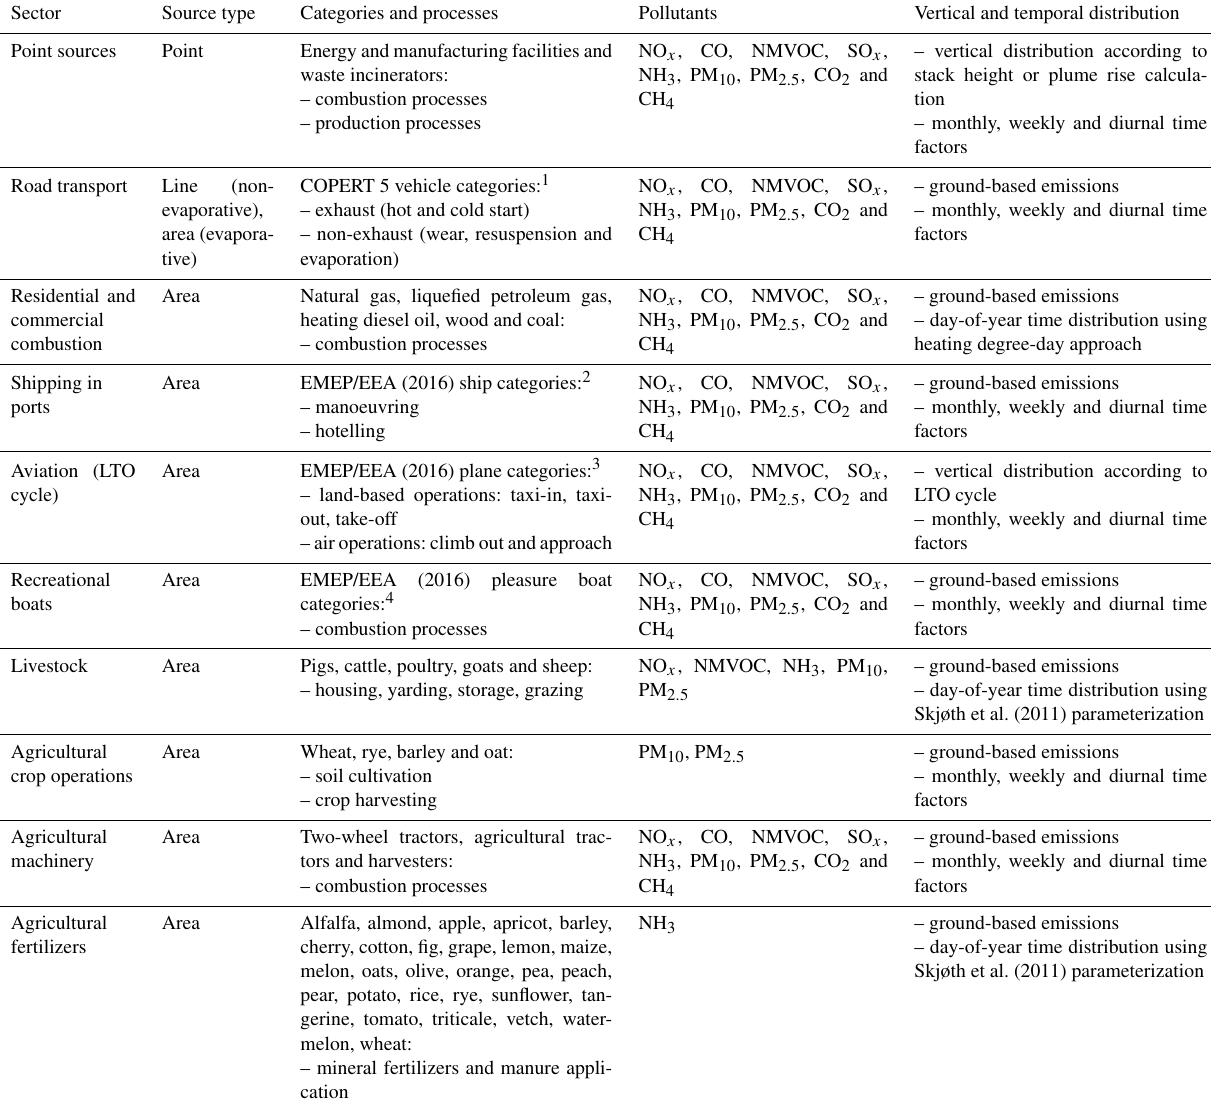
Table 1. Summary of the main characteristics of each pollutant sector included in HERMESv3_BU. Sector Source type Categories and processes Pollutants Vertical and temporal distribution Point